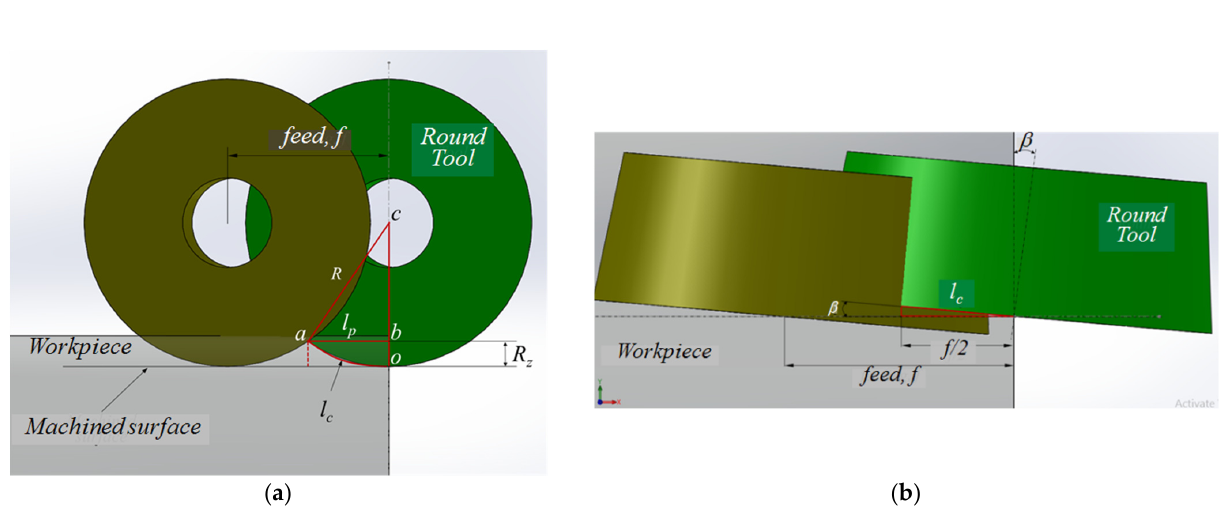
Figure 9. Conceptual model of the relationship of tool inclination angles and surface roughness: ( a ) the geometrical relationship between cutting contact and round tool radius; ( b ) the relation between inclination angle of tool and feed.